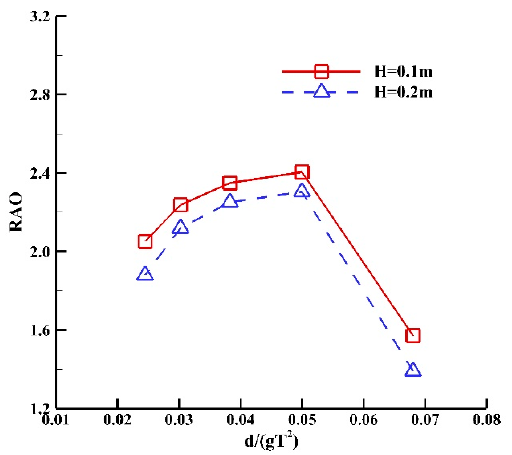
Figure 12. Effects of wave conditions on hydrodynamic performance of the buoy. Figure 12. E ff ects of wave conditions on hydrodynamic performance of the buoy.